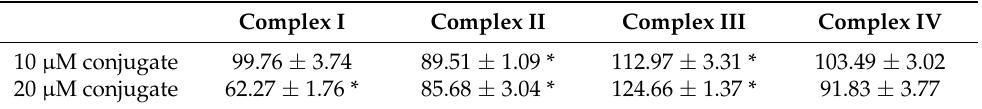
Table 3. Effect of F16-betulin on the activity of complexes of the electron transport chain of liver mitochondria (expressed in percentage vs